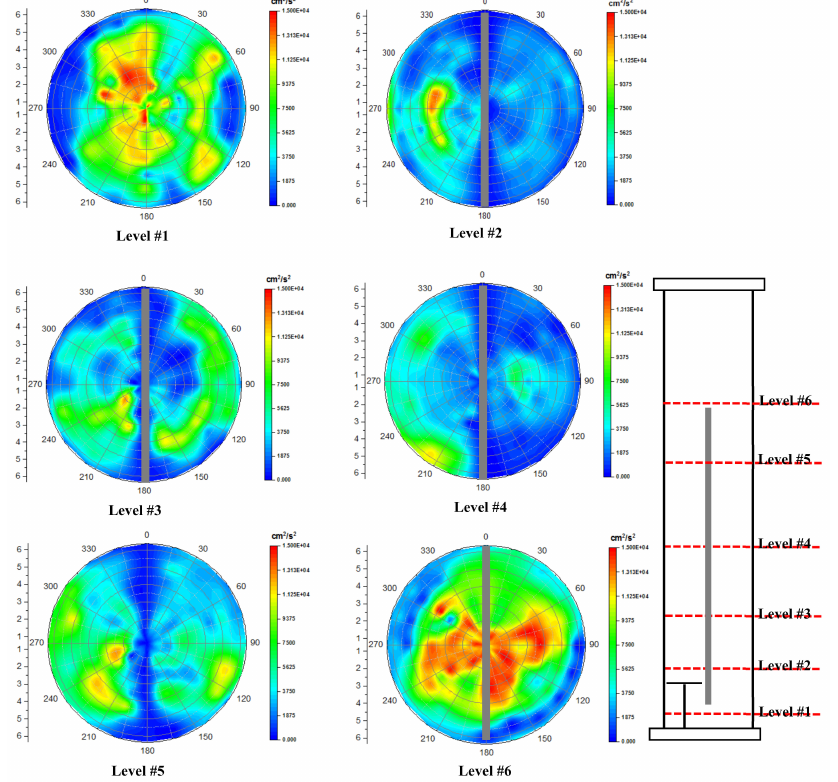
Figure 20. Cross-sectional distributions of turbulent kinetic energy at different heights of split airlift reactor operated under gas velocity of 1